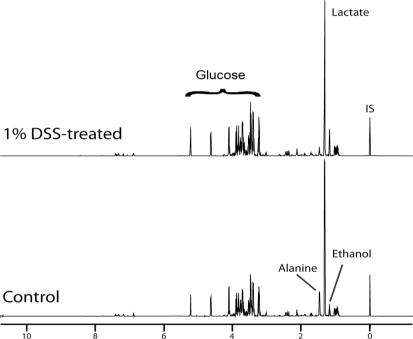
Representative 600 MHz 1H NMR spectra obtained from cell supernatant extracts from control and DSS-treated Caco-2 cells. IS (internal standard) represents sodium 2, 2-dimethyl-2-silapentane-5-sulfonate used as chemical shift reference. Ethanol is a contaminant.